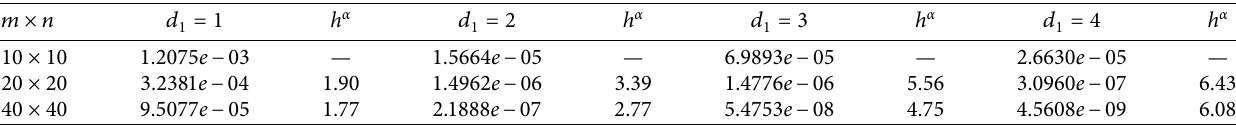
� 9 for Example 1. 2